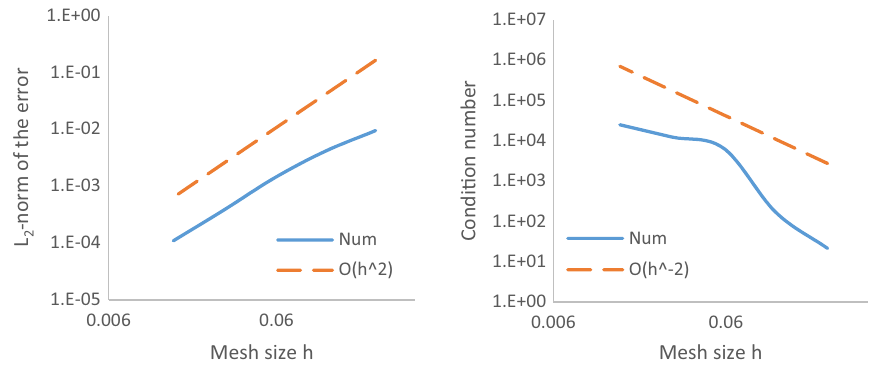
Fig. 20 Plot of the L 2 -norm of the error and 2-norm condition